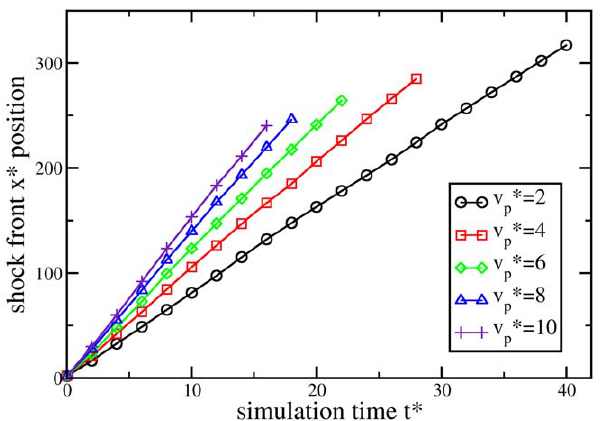
Figure 6. Propagation of shock-waves through a system simulated using both SPH and MD/DPDE. The shock-waves travel at of different speeds, corresponding to different particle velocities v p , and therefore reach the end of the simulation box at different times. ^ 24 : 9 to v (cid:1) ^ 9 : 9 , while the speed of Shock wave speeds range from v (cid:1) s s ^ 4 : 7 sound in the corresponding equilibrium system is c (cid:1) 0